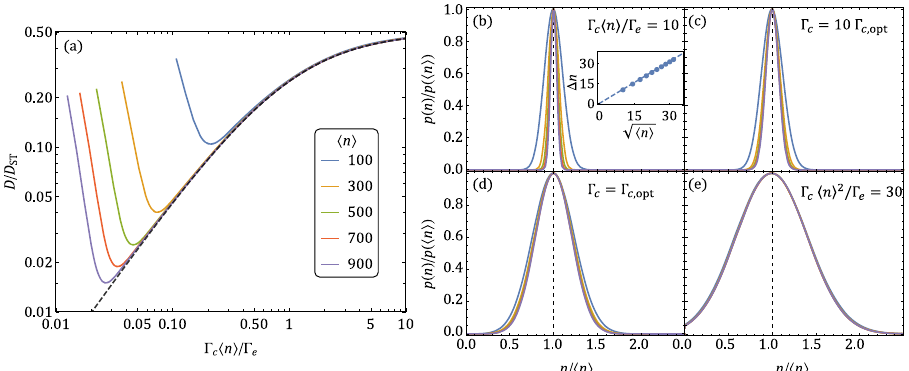
Fig. 3 The linewidth and the photon distribution of the Susskind – Glogower Bare Operator (SGBO) laser. a Minimum laser linewidth can be achieved by tuning the ratio of power emitted by conventional ( 〈 n 〉 Γ c ) and bare operator ( Γ e ) loss for different cavity occupancies. The dotted line represents Eq. (6). Photon number distributions are shown in b – e for four cases: conventional loss is dominant ( b ); intermediate conventional loss ( c ); minimum linewidth ( d ); and conventional loss is very weak ( e ). The lines in all sub fi gures are for the SGBO laser with 〈 n 〉 = 100 (blue), 300 (orange), 500 (green), 700 (salmon), and 900